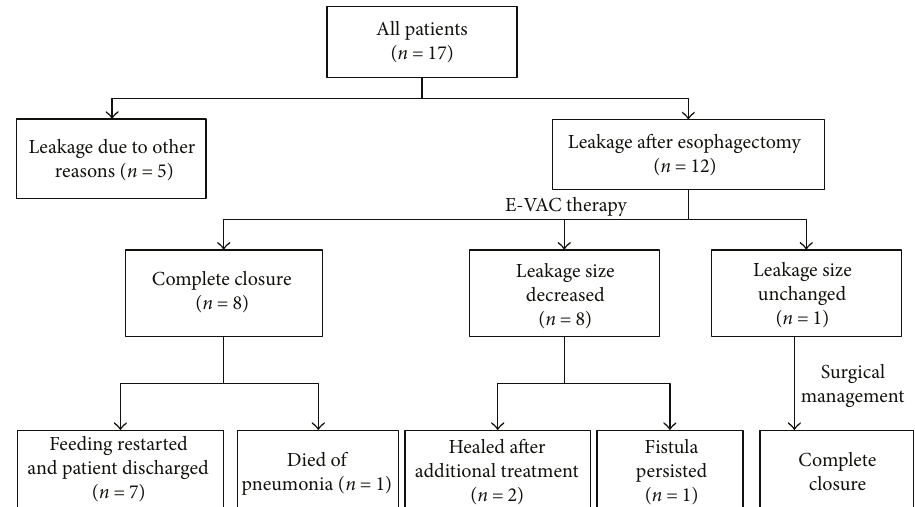
Figure 1: Flow chart of case